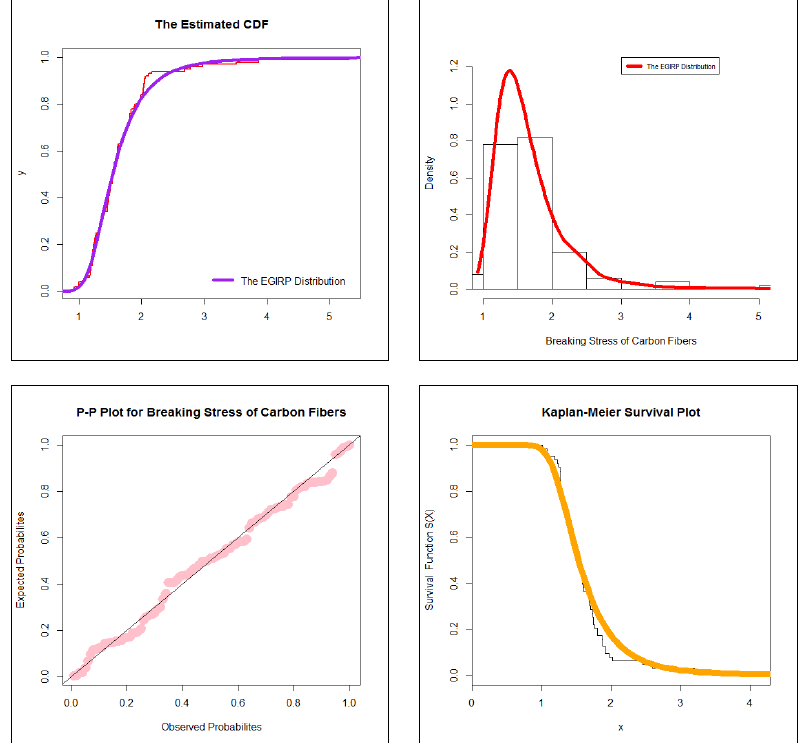
Figure 4. Estimated CDF ( top left ), estimated PDF ( top right ), P-P graph ( bottom left ), and Kaplan– Meier survival ( bottom right ) for the 1 st dataset.